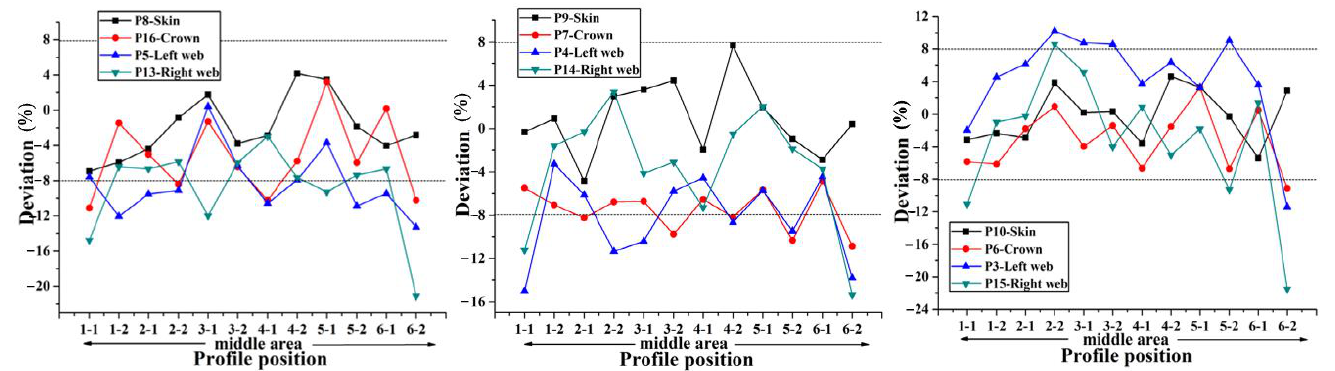
Figure 12. Comparison of dimensional stability of stringer manufactured by 50 HD bladder.